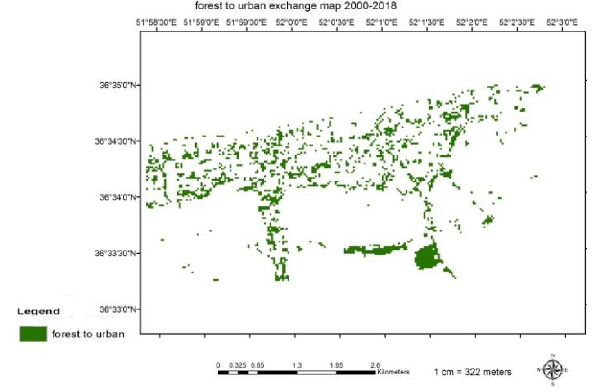
Figure 4. Forest to urban exchange map in 2000-2018; Deforestation has increased in 2018. 3.2 Above ground biomass (AGB) in forest area In this part, sentinel-1, sentinel-2 and ALOS PALSAR data are used. After pre-processing and extraction of indices, the AGB and the total carbon stock map of combination of them is estimated by GA-SVM matlab code. At the end, the carbon stock of urban green space (urban forest) on 2018 is acquired by the total carbon stock map and green space extraction on